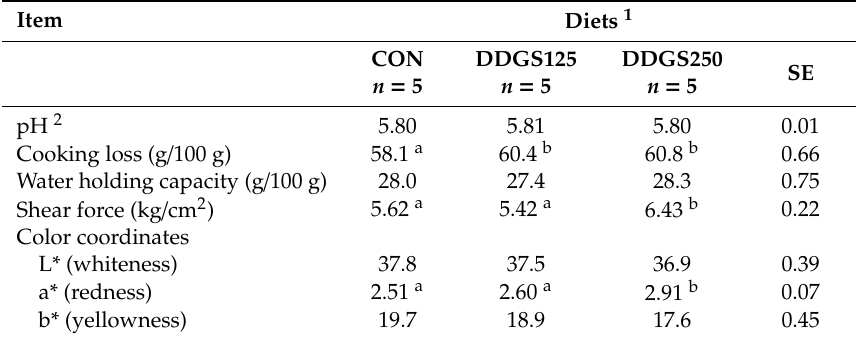
Table 6. E ff ects of feeding dried distillers’ grains with solubles (DDGS) on meat quality characteristics of growing Awassi